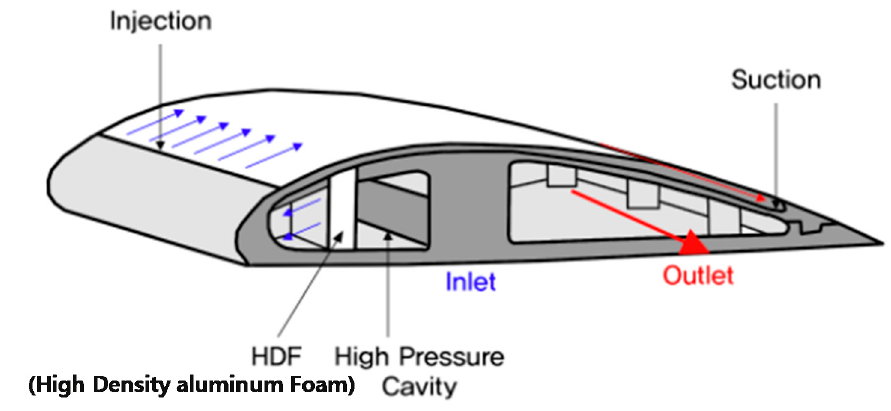
Figure 4. Operating principles of the CFJ Airfoil